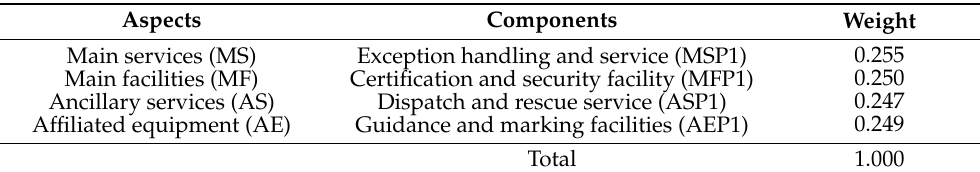
Table 13. The weights of the aspects and components.